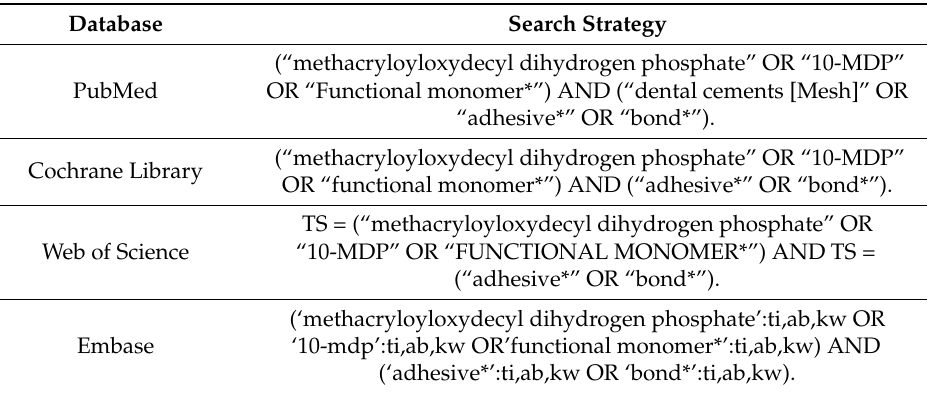
Table 2. Research strategy used.